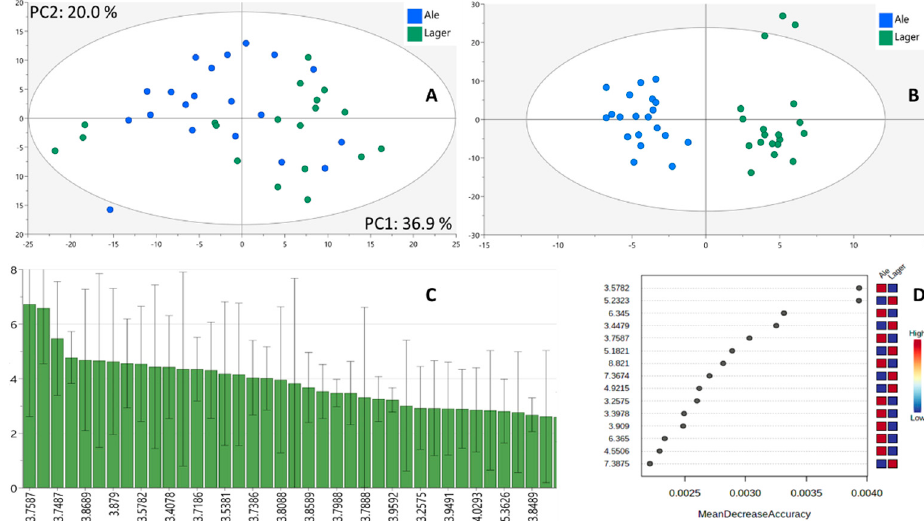
Figure 3. Principal component analysis (PCA) ( A ) and OPLS-DA scores plots ( B ) of ale and lager beers from 1D 1 H NMR aligned using ICOSHIFT. Variable importance in projection (VIP) plot obtained by the OPLS-DA model showing the most significant variables for the classification ( C ) and variable importance plot obtained from random forest ( D ). Table 1. Effect of normalization method on OPLS-DA model performance. PQN, probabilistic quotient